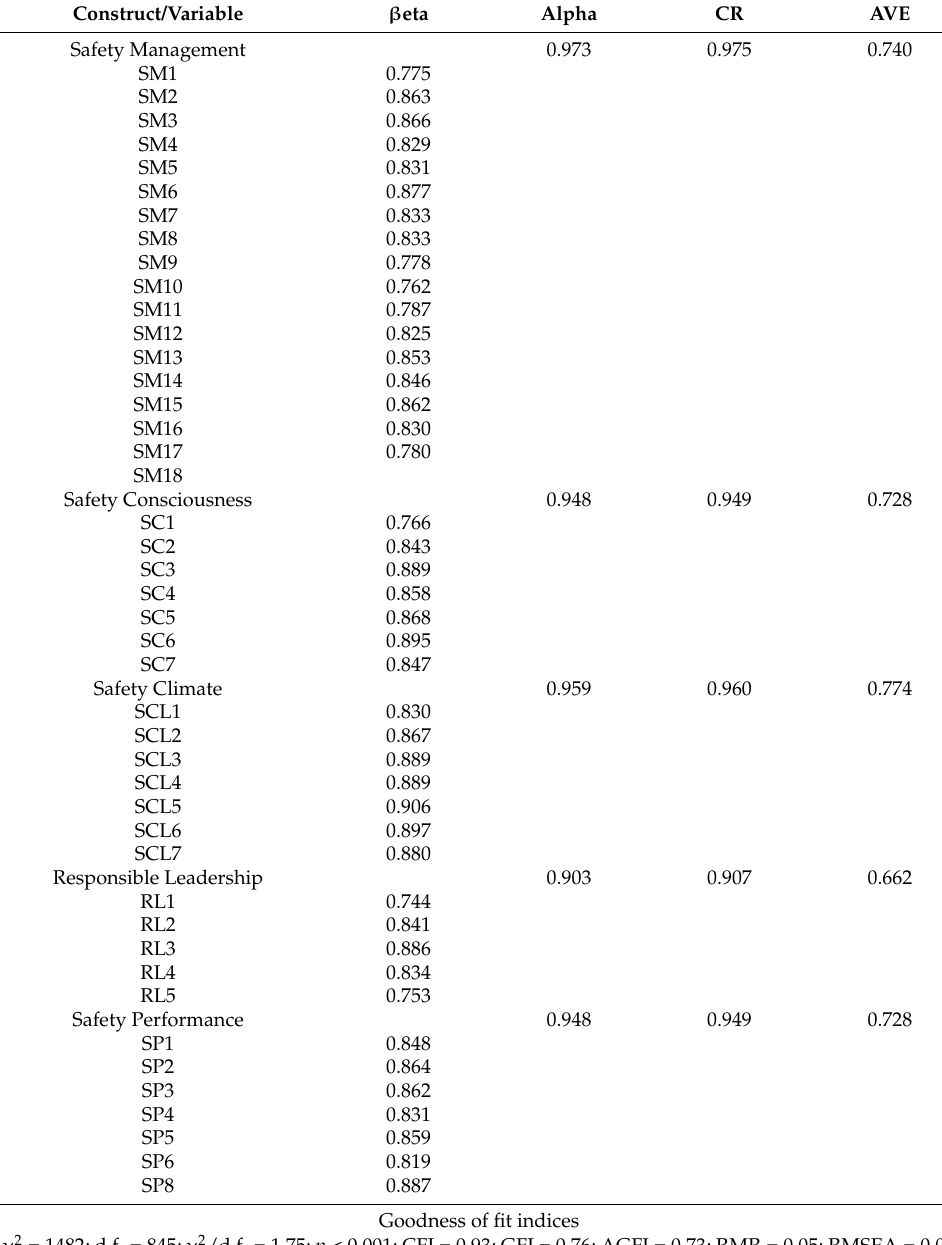
Table 1. Results of confirmatory factor analysis